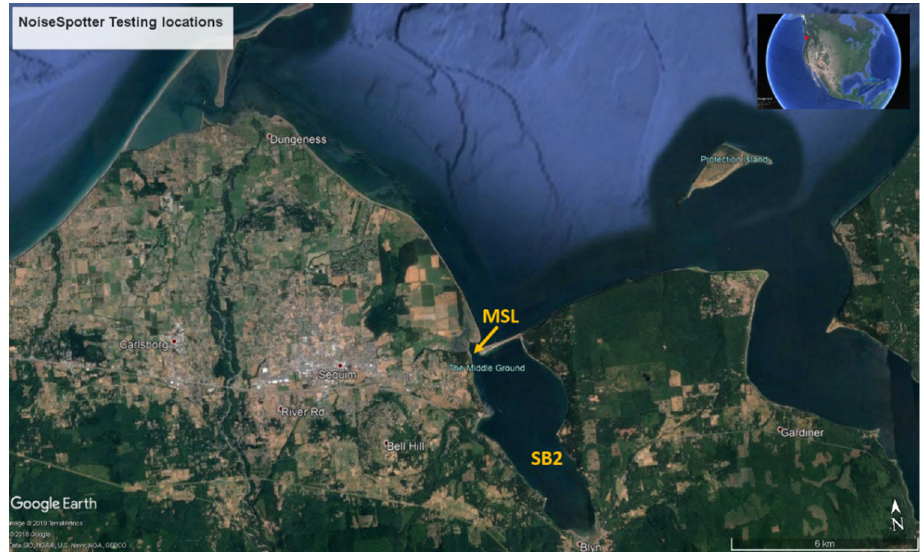
Figure 2. Map of NoiseSpotter testing locations.